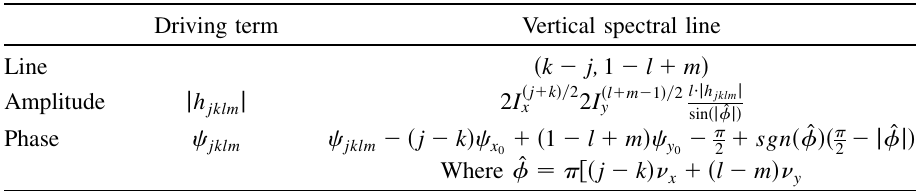
TABLE IV. General relation between the vertical spectral lines and the amplitude and phase Hamiltonian term, equivalent relations are found for the horizontal lines. of the h jklm Driving term Vertical spectral